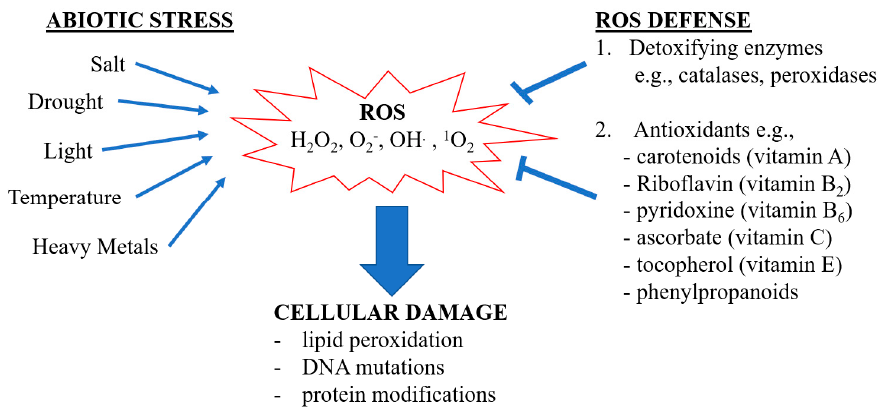
Figure 1. Reactive Oxygen Species Generation and Cellular Defense. Reactive oxygen species (ROS) production in cells increase under any prolonged abiotic stress condition such as salt, drought, or temperature stress. ROS increase can be detrimental for the cellular integrity as it may cause membrane damage (lipid peroxidation) or DNA and protein modifications. To prevent this, cells have developed sophisticated defense mechanisms that are either based on enzymatic activities or on secondary metabolites that act as antioxidants, and which can quench and detoxify ROS. These compounds can have similar health-promoting effects when consumed in the diet.